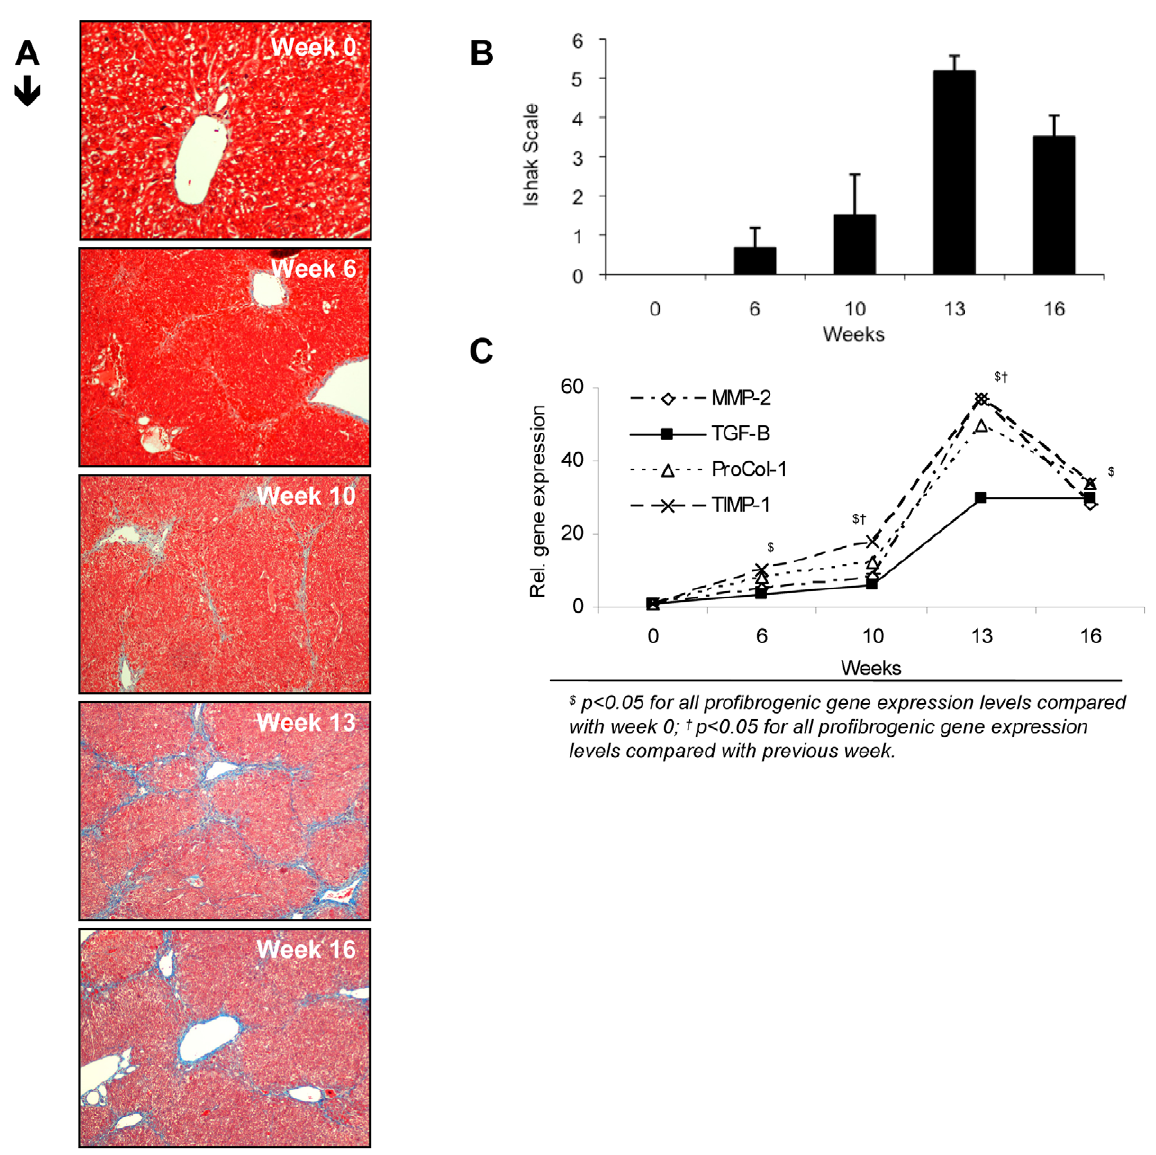
Figure 1. Fibrosis grade at laparotomy weeks along the study protocol in CCl4-treated mice. (A) Example of histological changes in CCl4- treated mice along the 16 weeks of study. Hepatic sections stained with Masson Trichrome (original magnification 6 10), showing light to strong blue staining, as a reflection of the collagen deposition at different stages of the liver disease: no histopathological changes (week 0); focal mild portal fibrosis with short fibrous septa (week 6); moderate collagen fibber deposition in portal areas with occasional portal bridging (week 10); marked fibrosis in the majority of portal spaces with frequent portal-portal and portal-central bridging and architectural distortion (regenerative nodules) (weeks 13 and 16). (B) Fibrosis grade according to Ishak Scale in treated animals (n=6/week) at different study weeks are represented as mean 6 standard deviation. (C) Relative gene expression levels of different profibrogenic genes at different study weeks. MMP-2: Matrix metalloproteinase 2; TGF- b . Tumour growth factor beta; ProCol-1: Procollagen alpha-1(1); TIMP-1: Tissue inhibitor of metalloproteinase 1. Mean values of CCl4-treated mice (n=6/week) are represented.